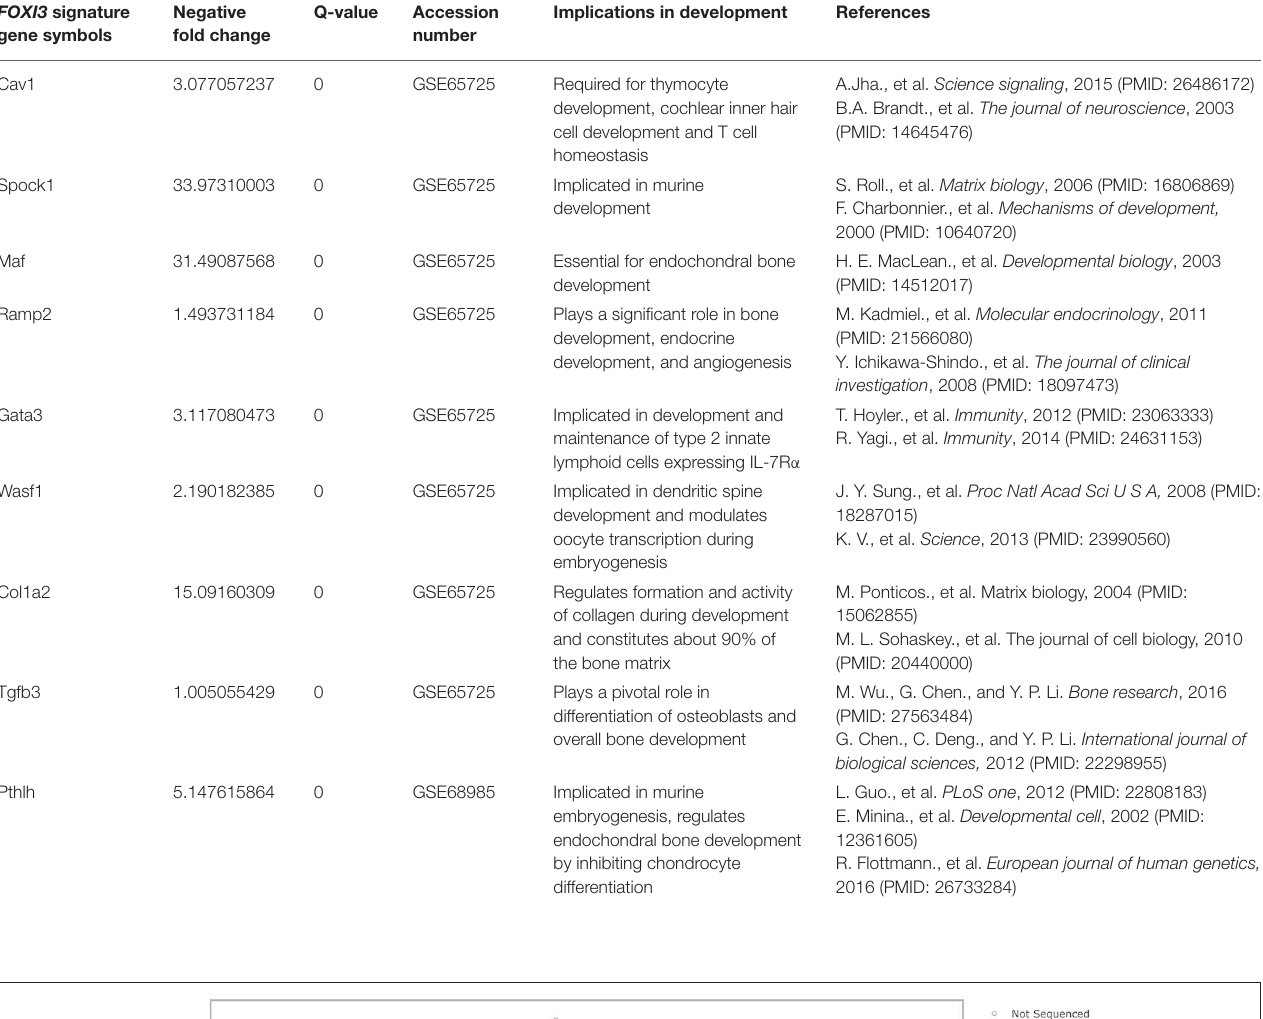
TABLE 1 | Role of FOXI3 signature genes in early development. FOXI3 signature gene symbols